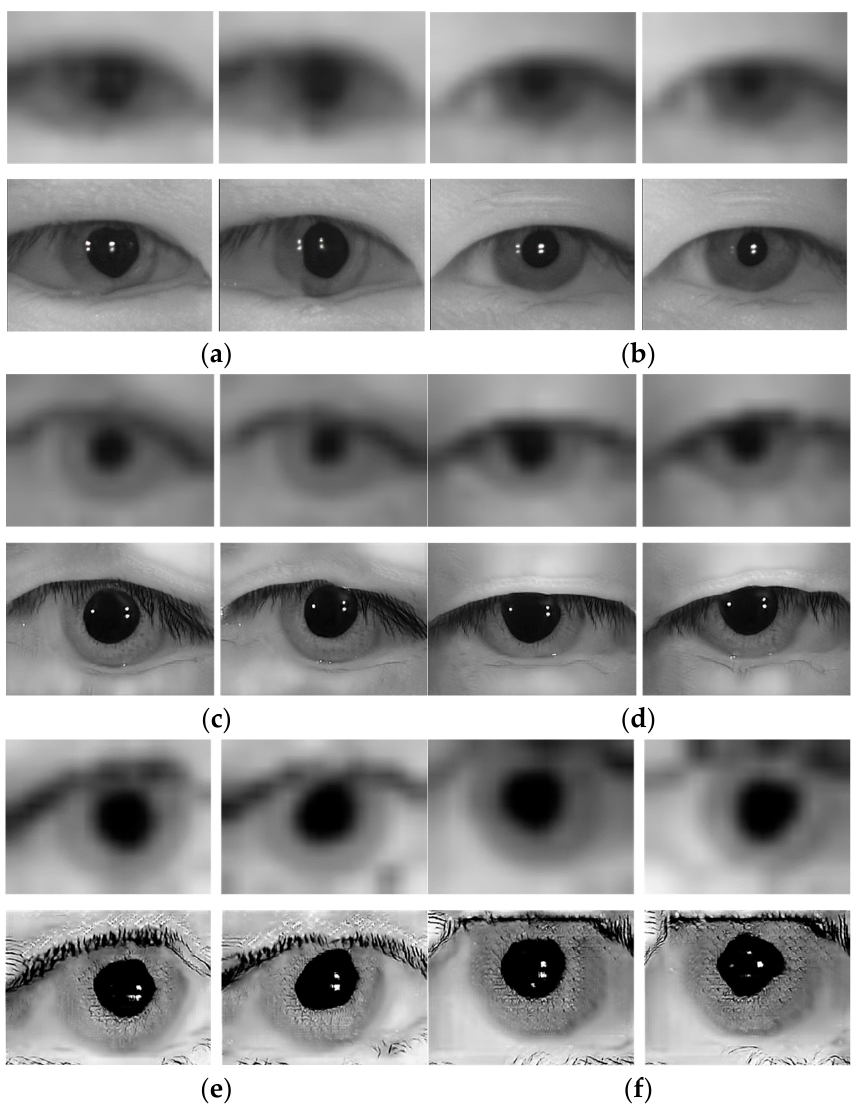
Figure 7. Example of correct recognition cases by the proposed method. ( a , b ) CASIA-Iris-Distance database. ( c , d ) CASIA-Iris-Lamp database. ( e , f ) IIT Delhi iris database. The left-hand and right-hand side images in ( a – f ) show registered images and recognition images, respectively. 1st and 2nd row images in ( a – f ) show low-resolution and high-resolution images restored by OSRCycleGAN, re- spectively.